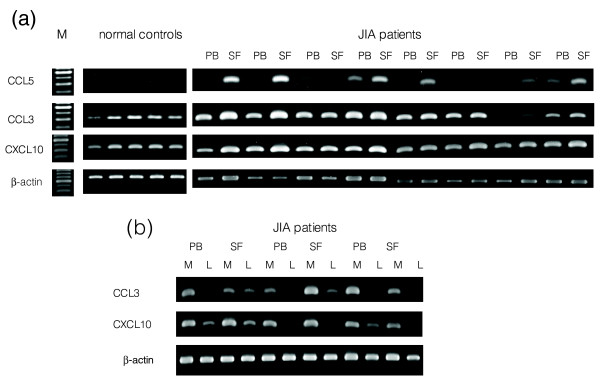
Expression of mRNA for three inflammatory chemokines in juvenile idiopathic arthritis. (a) Amplification products of mRNA for CCL5, CCL3 and CXCL10 after RT-PCR from peripheral blood (PB) and synovial fluid (SF) mononuclear cells from patients (n = 8) with juvenile idiopathic arthritis (JIA; 5 persistent oligoarticular, 3 extended oligoarticular) and 5 controls. Amplification of β-actin acted as control. (b) Amplification of mRNA for CCL3, CXCL10 and β-actin from myeloid (M) or lymphoid (L) cells purified from three representative JIA patients (one persistent oligoarticular, one extended oligoarticular, and one polyarticular).